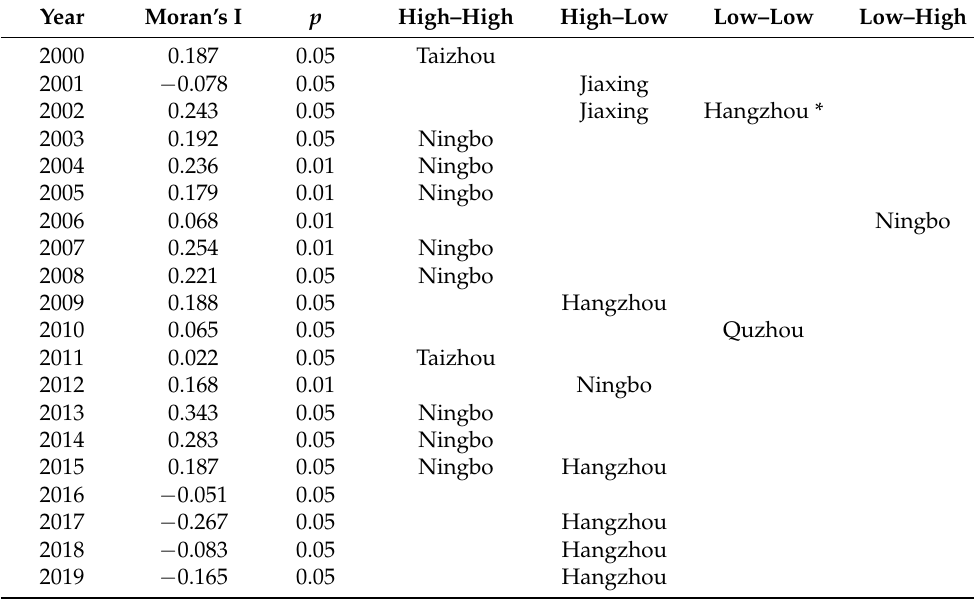
Table 4. Moran index values and regions passing the significance test over the years. Year Moran’s I p High–High High–Low Low–Low